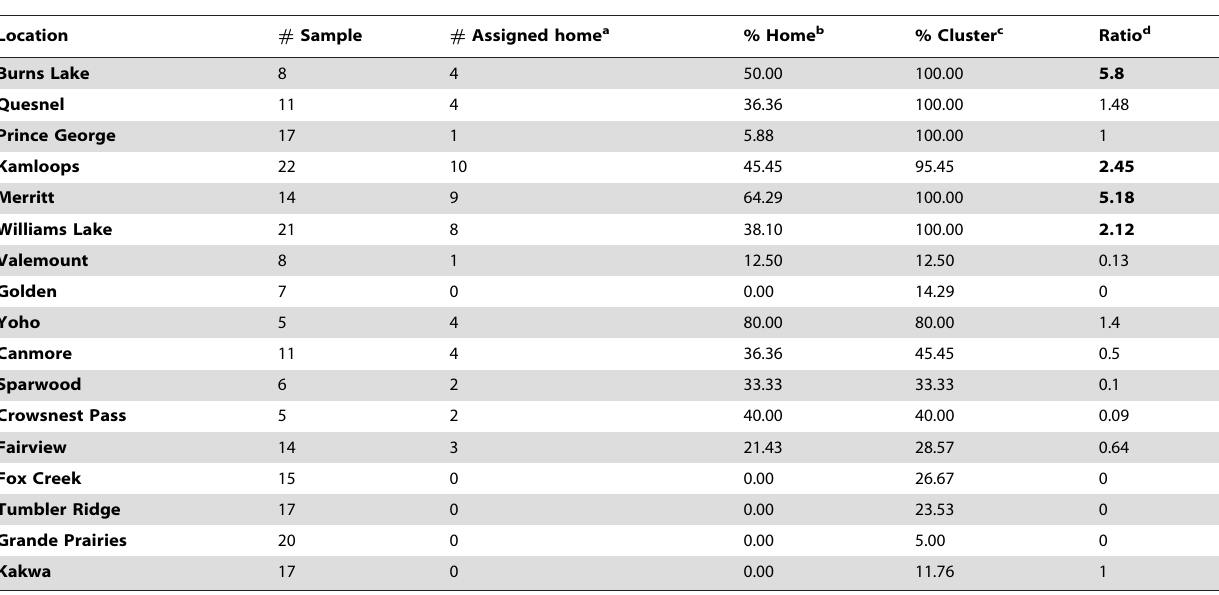
Table 4. Results of individual assignment from GENECLASS.